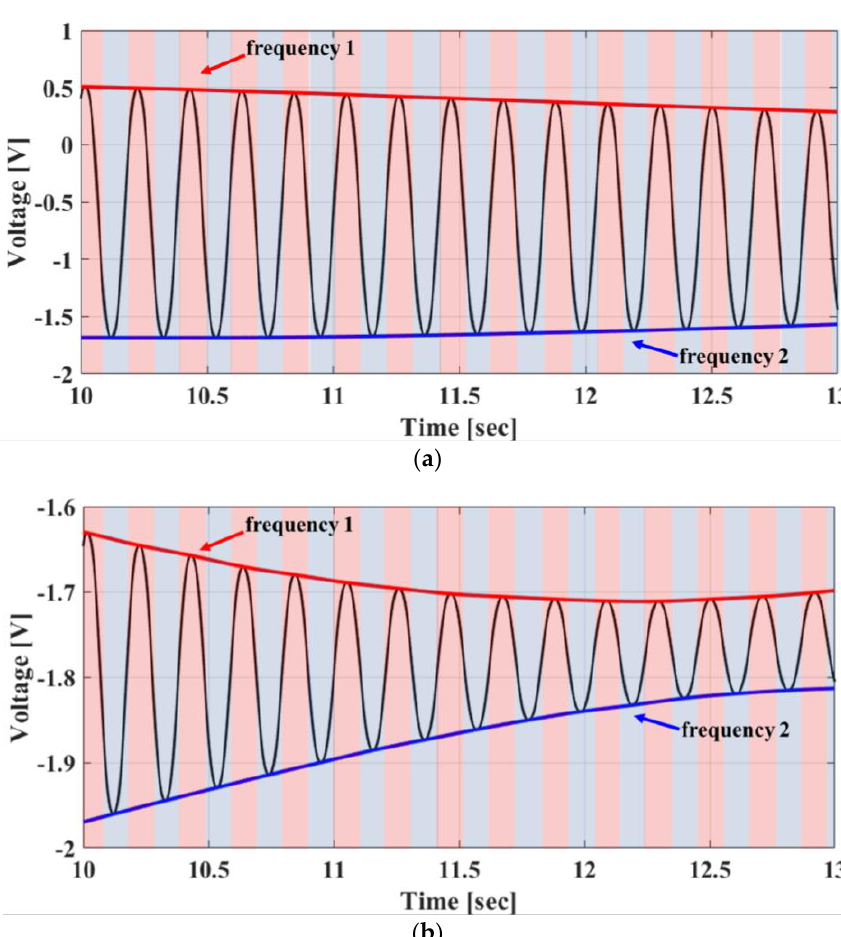
Figure 3. Proposed envelope detection method for discriminating the baseband signals at each operating frequency of the FSK radar. The frequency-control signal of the signal generator, which is indicated by red and blue shaders in the waveform, is used for synchronous data acquisition: ( a ) In-phase channel signals; ( b ) quadrature channel signals.